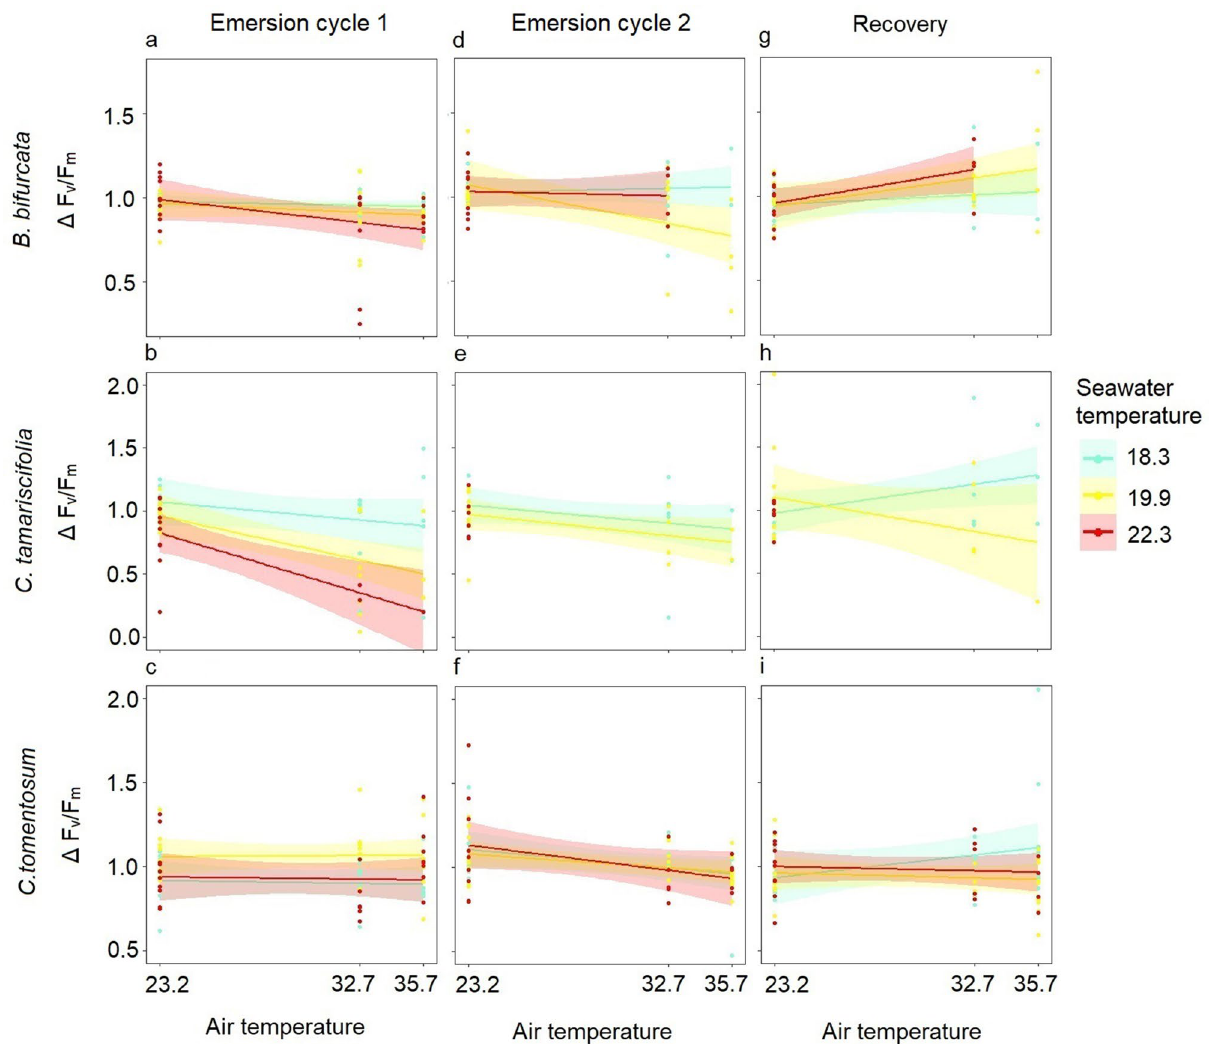
Figure 4. Trends in Δ F v /F m as a function of temperature treatments (air temperature: control ~ 23.2 °C, atmospheric heatwave ~ 32.7 °C and extreme atmospheric heatwave ~ 35.7 °C; seawater temperature: control ~ 18.3 °C, marine heatwave ~ 19.9 °C and extreme marine heatwave ~ 22.3 °C) after the emersion cycles ( a – f ) and recovery periods ( g – i ) in the laboratory experiment. The points are the replicates and the smoothed curves are the data fitted by GLMs with a confidence interval of 95%. Note that due to an insufficient number of replicates, the effect of the highest air temperature level (35.7 °C) on the ∆F v /F m of B. bifurcata after the second emersion cycle was not formally modelled. Likewise, the effect of air temperature on the ∆F v /F m of C. tamariscifolia after the two emersion cycles was not formally